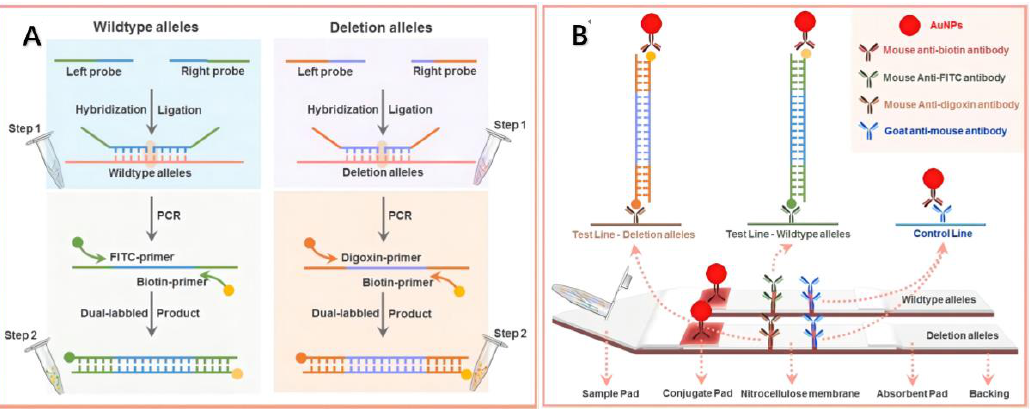
Figure 4. Rapid-MLPA and dual-LFNAB cascade for detecting genome editing-induced deletion [26]. Brief summary of work flow ( A ); Rapid-MLPA procedure ( B